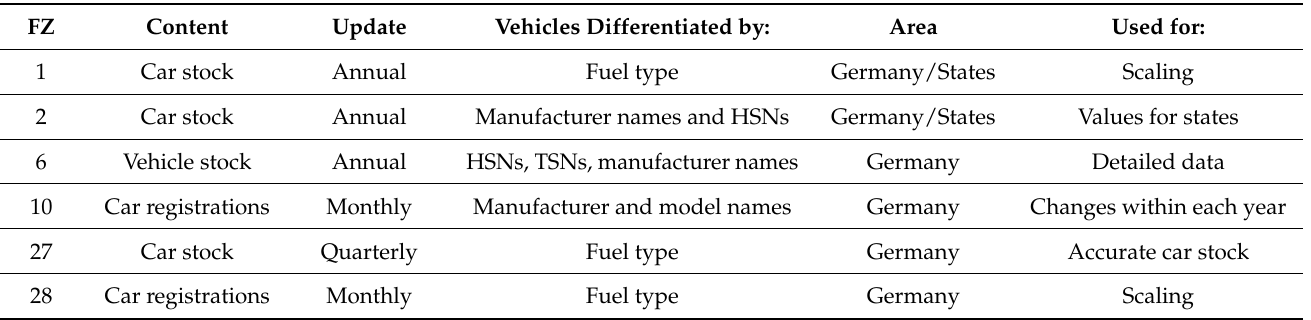
Table 1. Data sources offered by the KBA